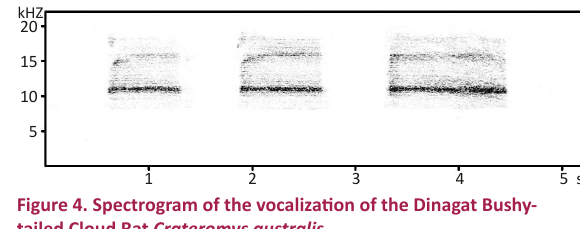
Figure 4. Spectrogram of the vocalization of the Dinagat Bushy- tailed Cloud Rat Crateromys australis